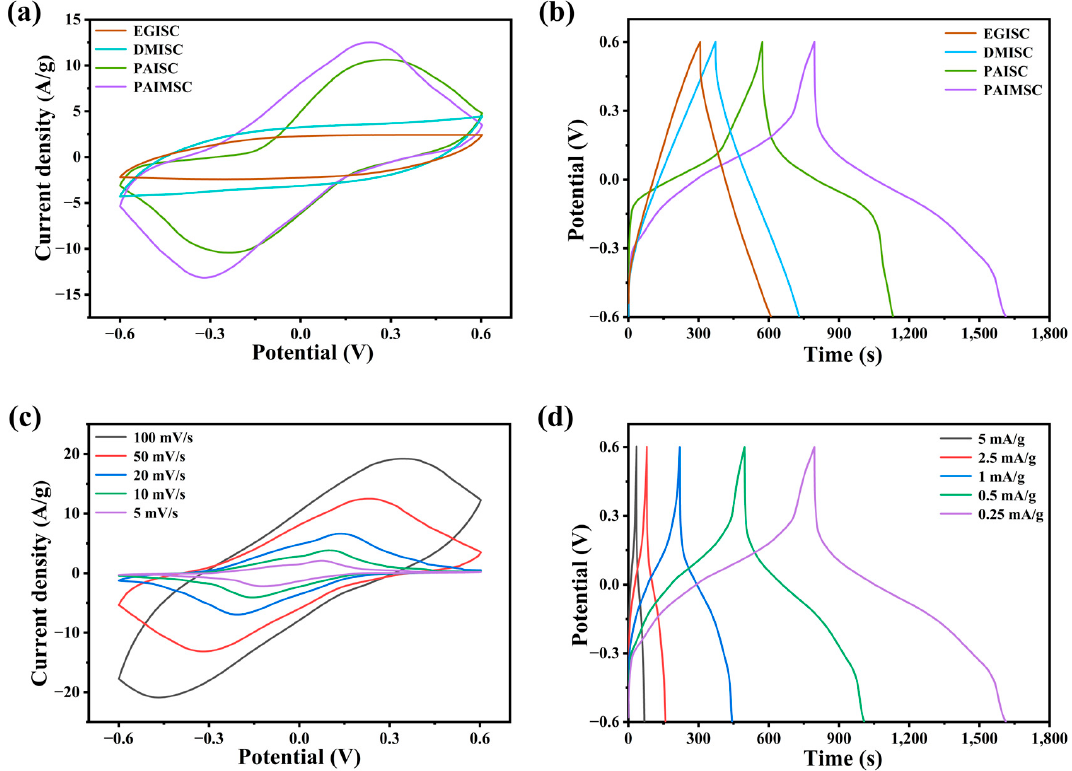
Figure 4. ( a ) CV curves of four devices (EGISC, DMISC, PAISC, and PAIMSC) at 50 mV/s. ( b ) GCD curves of four devices at 0.25 mA/g. ( c ) CV curves of PAIMSC devices at different scanning rates. ( d ) GCD curves of PAIMSC at different current densities.